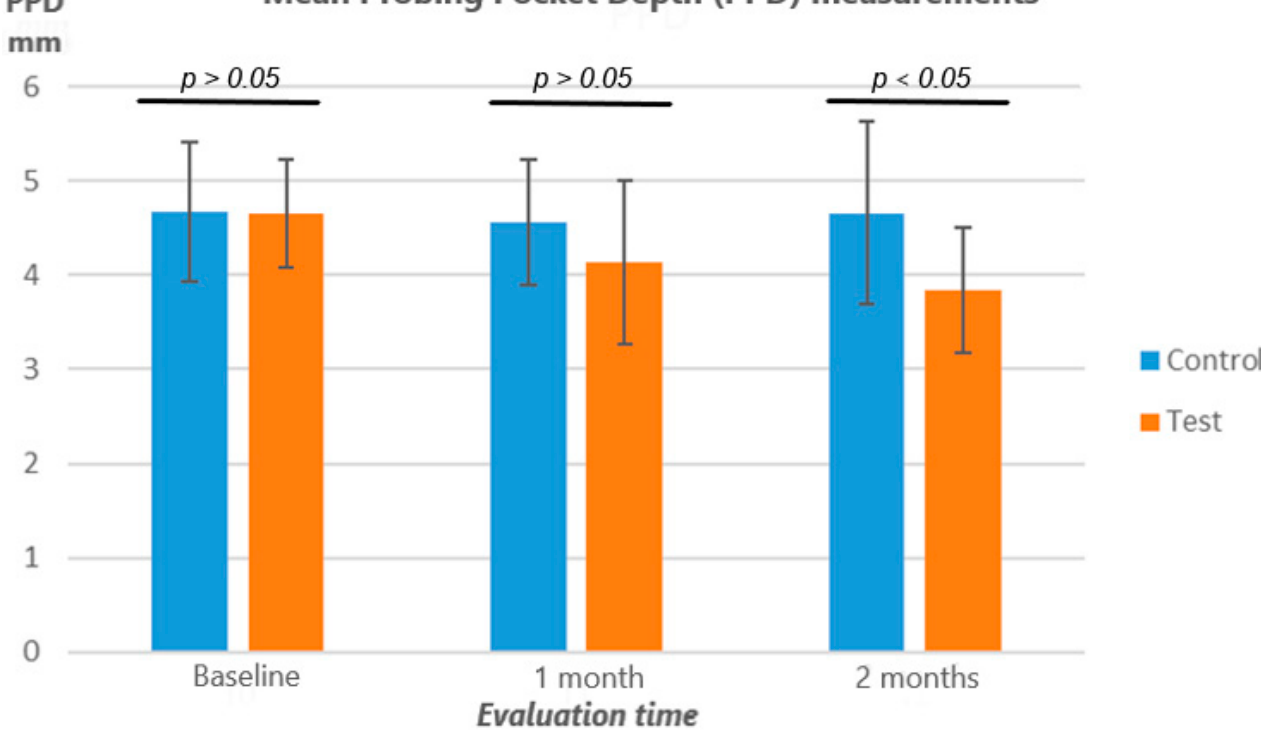
Table 3. Descriptive statistics of Plaque Index measurements (PI%).